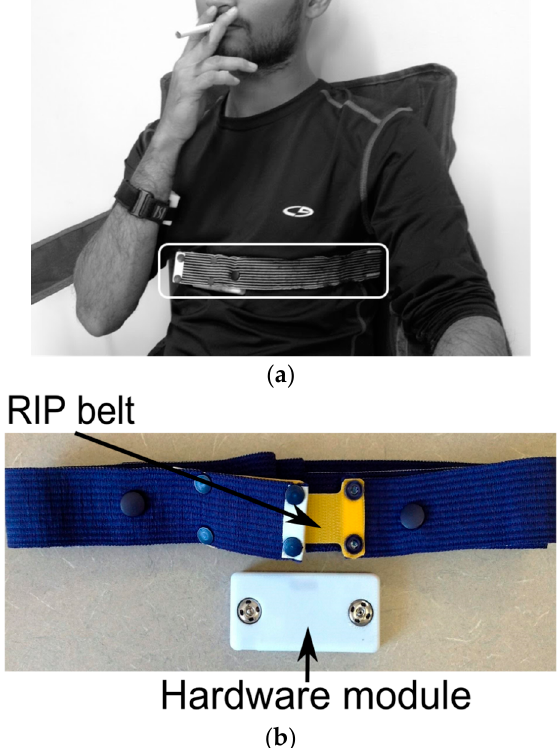
Figure 6. ( a ) RIP breathing sensor on chest; ( b ) sensor Figure 6. (a) RIP breathing sensor on chest; ( b )sensor components